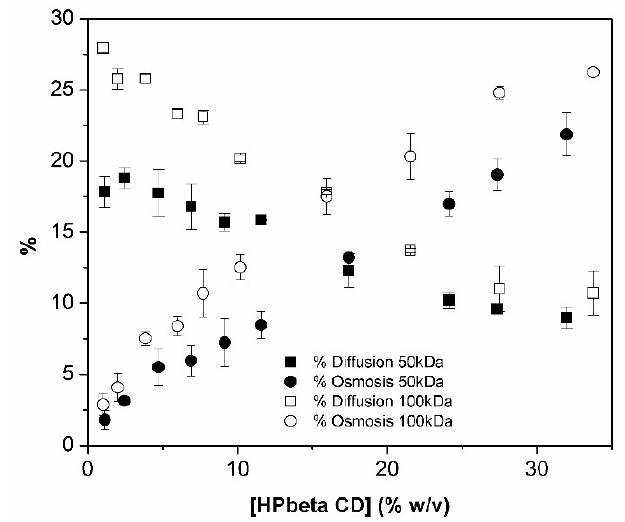
Figure 7. % osmosis (circles) and % diffusion (squares) determined for aqueous HPβCD solutions when studies used different MWCO semipermeable membranes: 50 kDa (black) and 100 kDa (white) (n = 3).